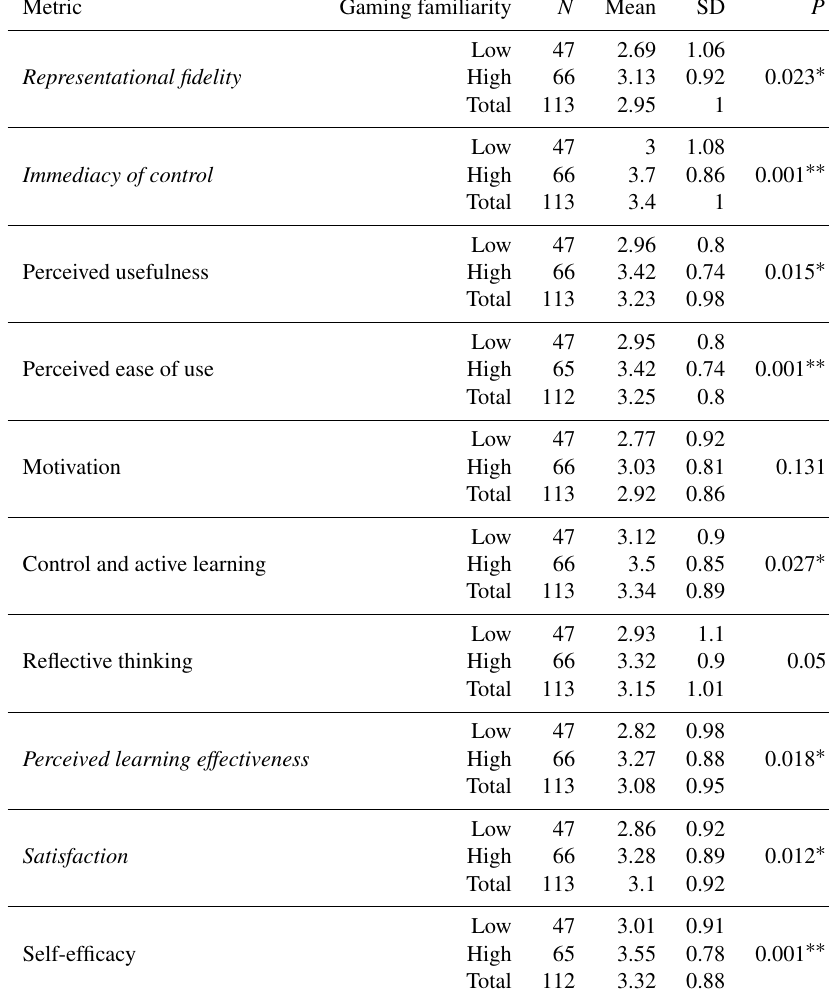
Table 4. Results of an independent samples t test comparing students grouped by gaming familiarity. Metric Gaming familiarity Representational